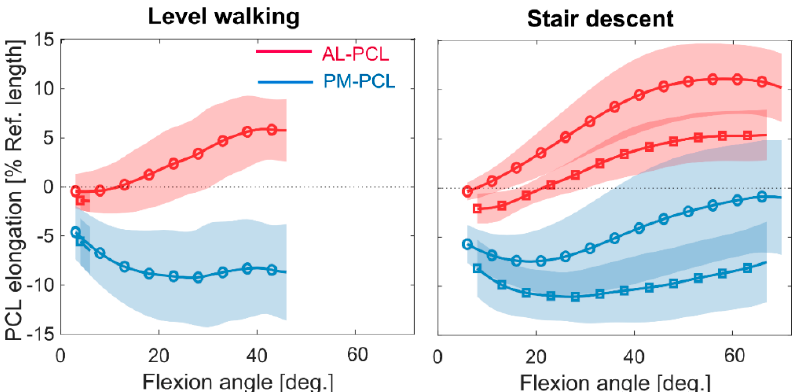
Figure 3. Elongation patterns of the two PCL bundles during stance phase (square markers) and swing phase (circle markers) of level walking ( left ) and stair descent ( right ). Average patterns and standard deviations (shadings) were calculated only over the flexion ranges achieved by all subjects during all the five included cycles.